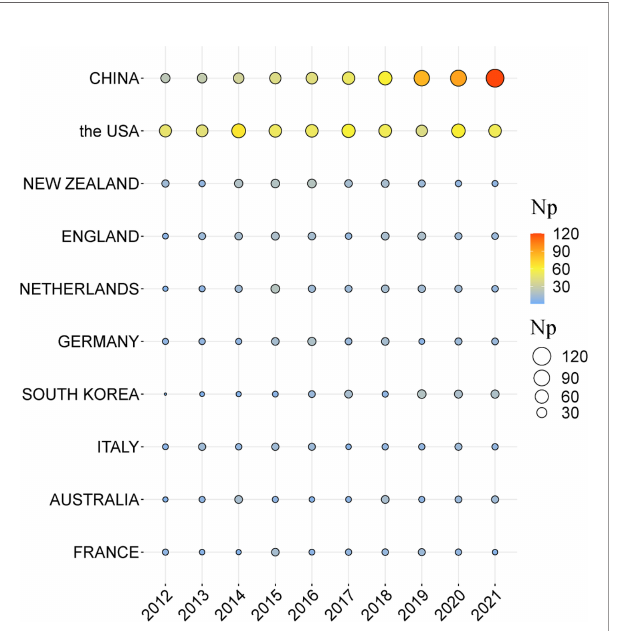
FIGURE 2 | Top 10 countries in terms of annual publications on GA research, from 2012-2021. The circle ’ s size and colours show the number of papers. The larger the circle, the colour from light blue to red, the higher the number of articles issued in that country.